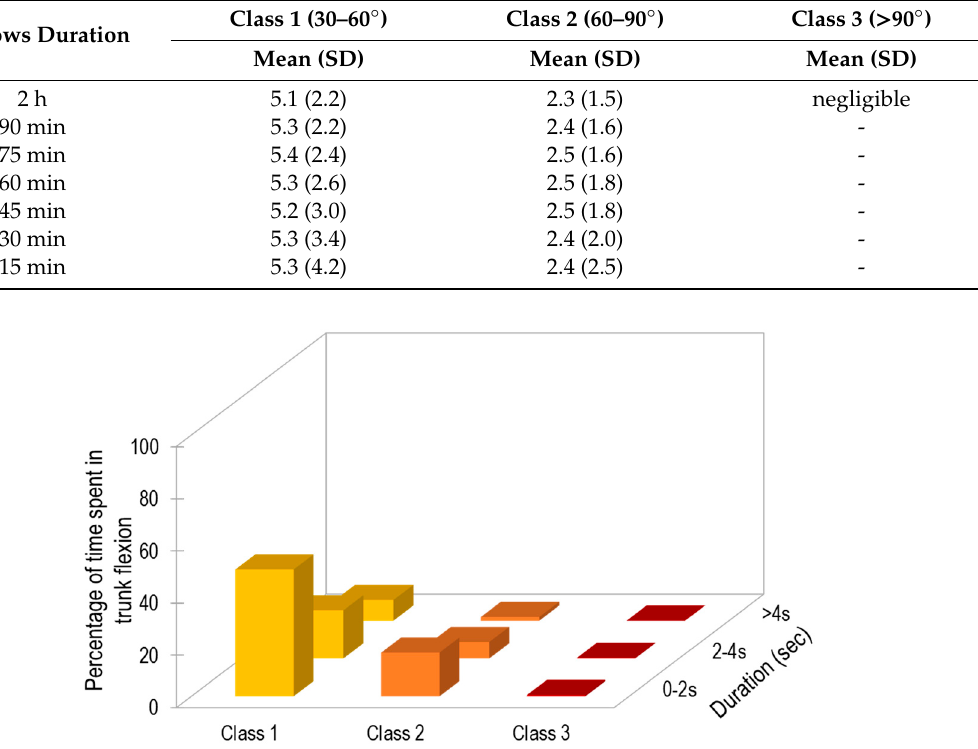
Figure 3. Results from exposure variation analysis of trunk flexion. Bars represent the percentage of time spent in different categories of trunk flexion, based on flexion amplitude and duration. This representation captures the distribution of flexion pattern (e.g., nearly 70% of flexed posture occurred for less than two seconds and most trunk flexion was between 30° and 60°).